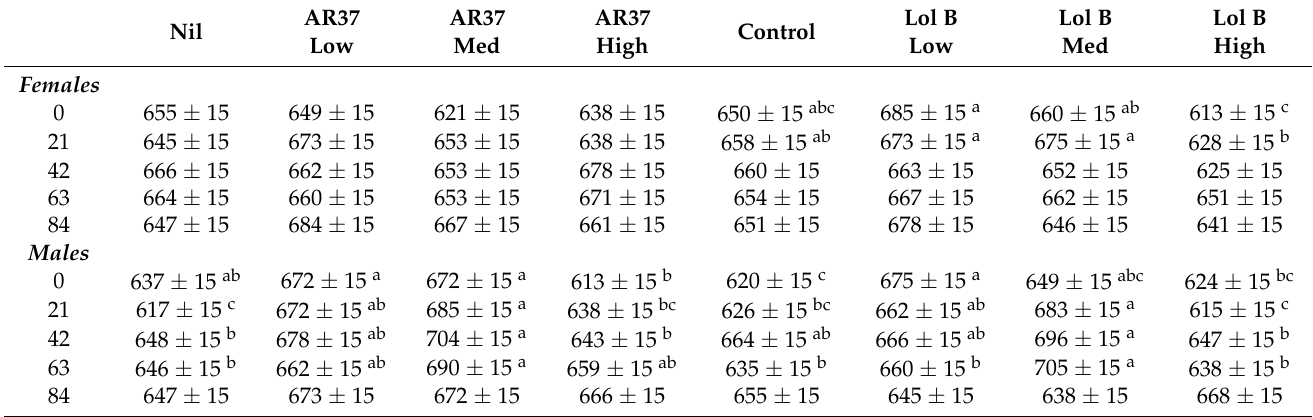
Table 2. Heart rate of mice fed a diet containing lolitrem B (0, 0.265, 0.53 or 1.06 ppm for control, low, med and high, respectively) or AR37 endophyte-infected seed diet (0, 7.5, 15 or 30% for nil, low, med and high,